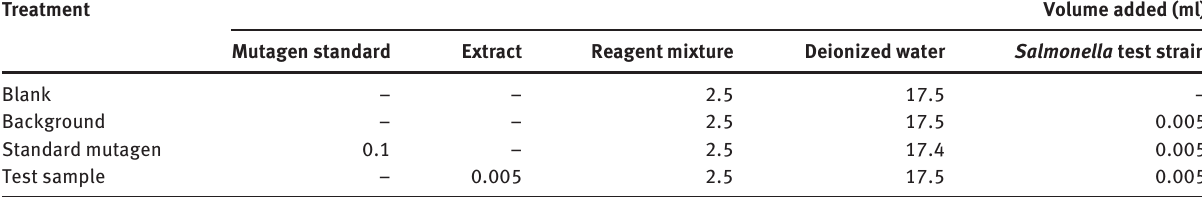
Table 1: Set-up of the fluctuation